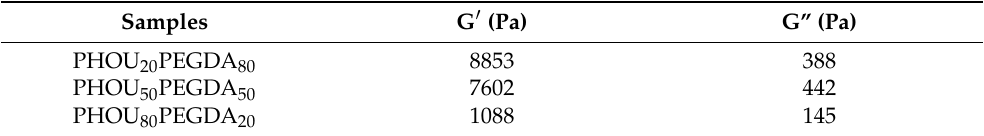
Table 4. G (cid:48) and G (cid:48)(cid:48) values of networks at 10 Hz. Samples G (cid:48)